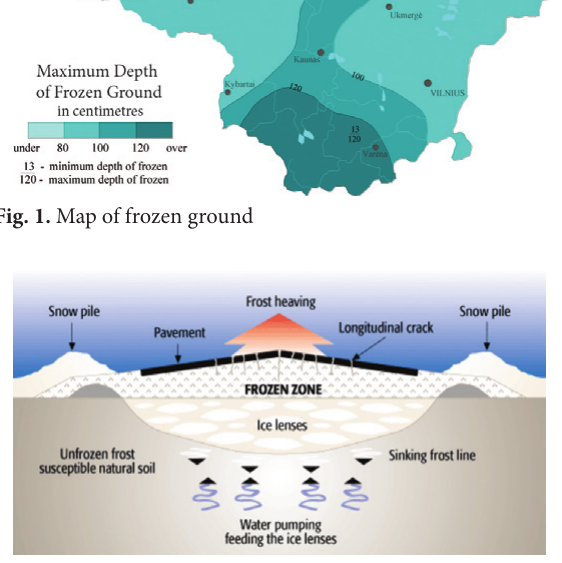
Fig. 2. Freezing of soil in road structure (Tighe et al.